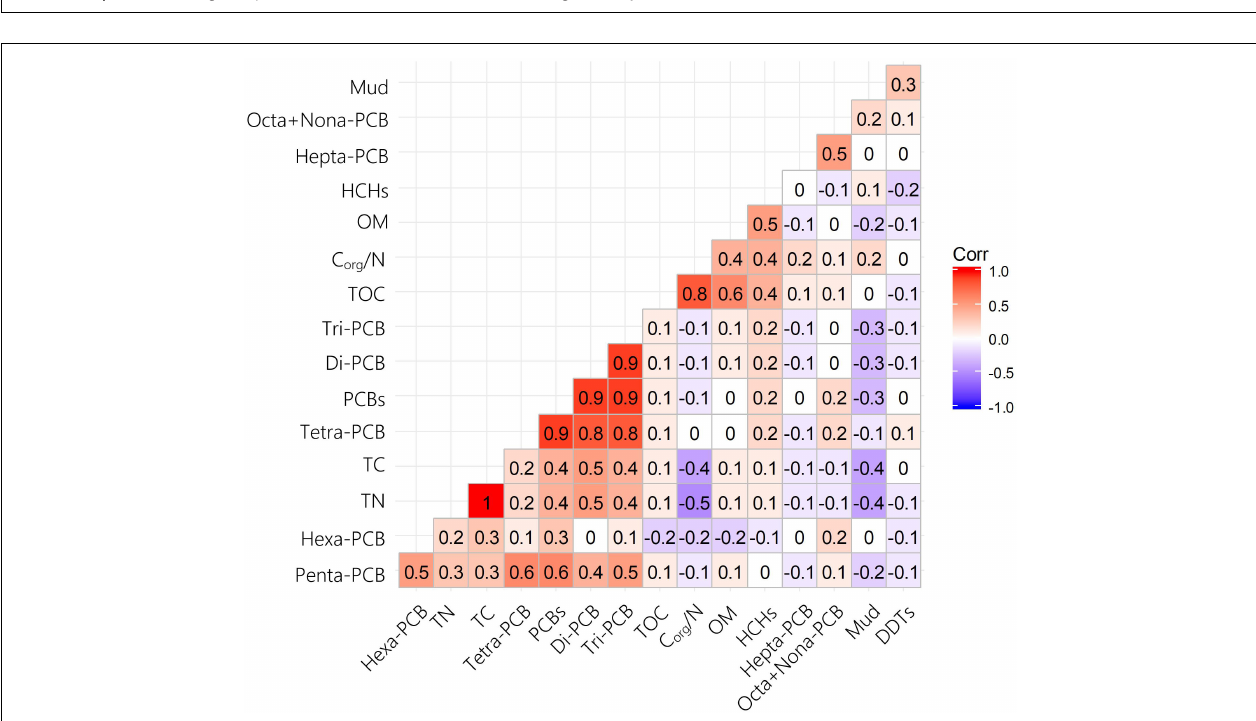
FIGURE 5 | Pearson correlations of PCB homolog compositions and physicochemical characteristics of sediments in Qingduizi Bay.